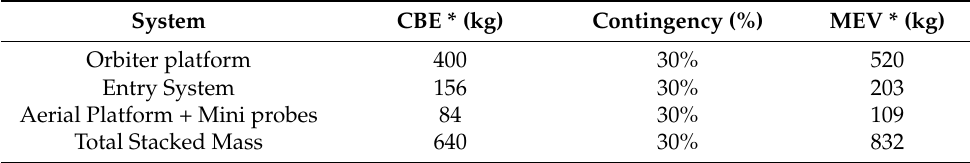
Table 3. Summary of mass of flight system elements.